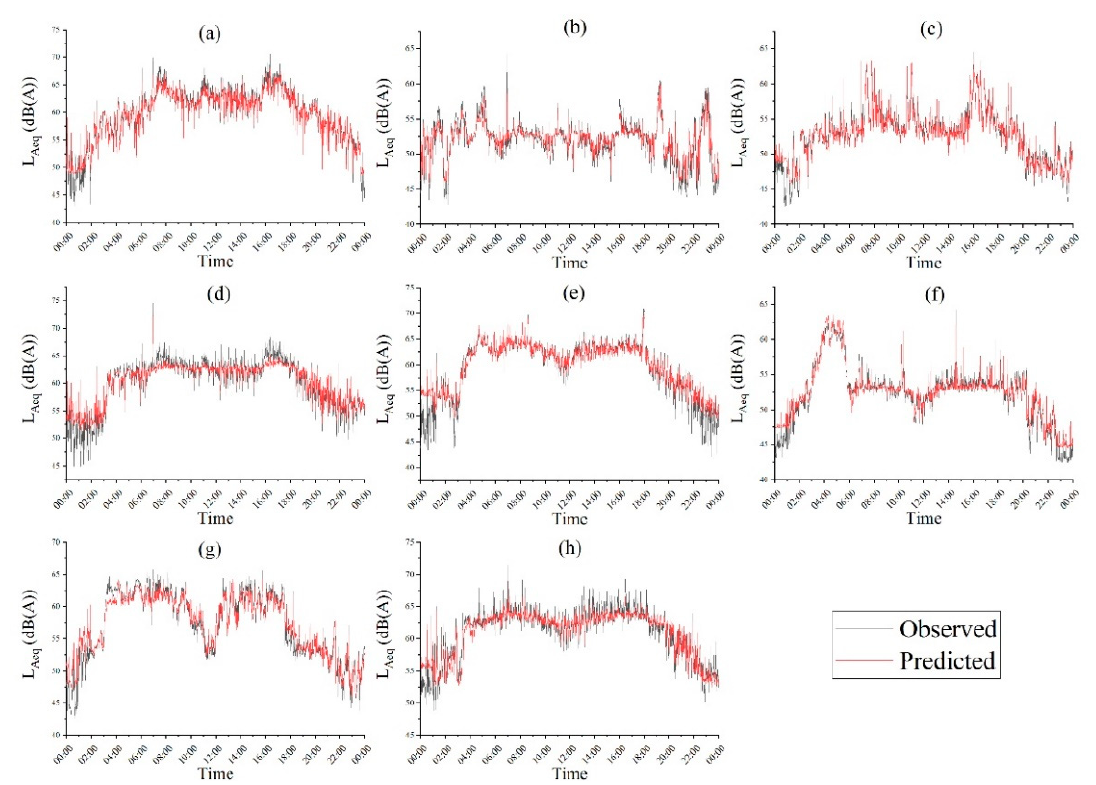
Figure7. Comparisonofobservedandpredictedone-daynoisevalueondi ff erentdatasets: ( a – h )dataset Figure 7. Comparison of observed and predicted one-day noise value on different data sets: ( a – h ) 01_a, 02_a, 03_a, 04_a, 01_b, 02_b, 03_b, dataset 01_a, 02_a, 03_a, 04_a, 01_b, 02_b, 03_b, 04_b.